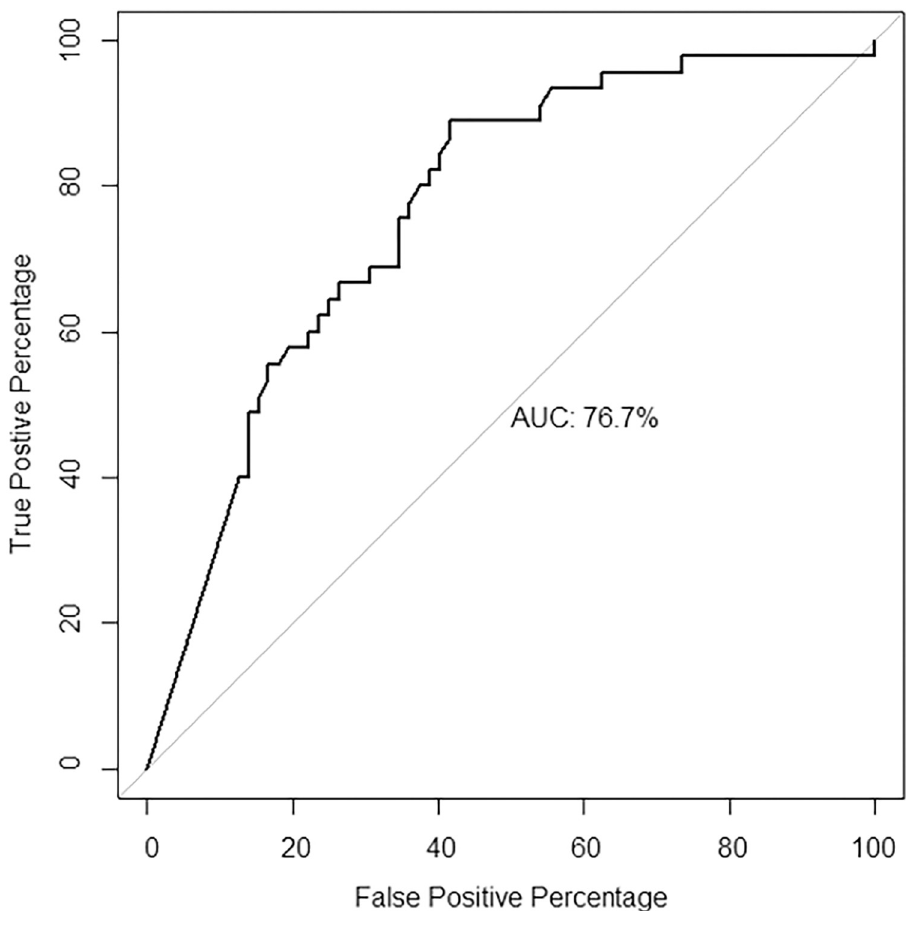
Fig 1. ROC-analysis by